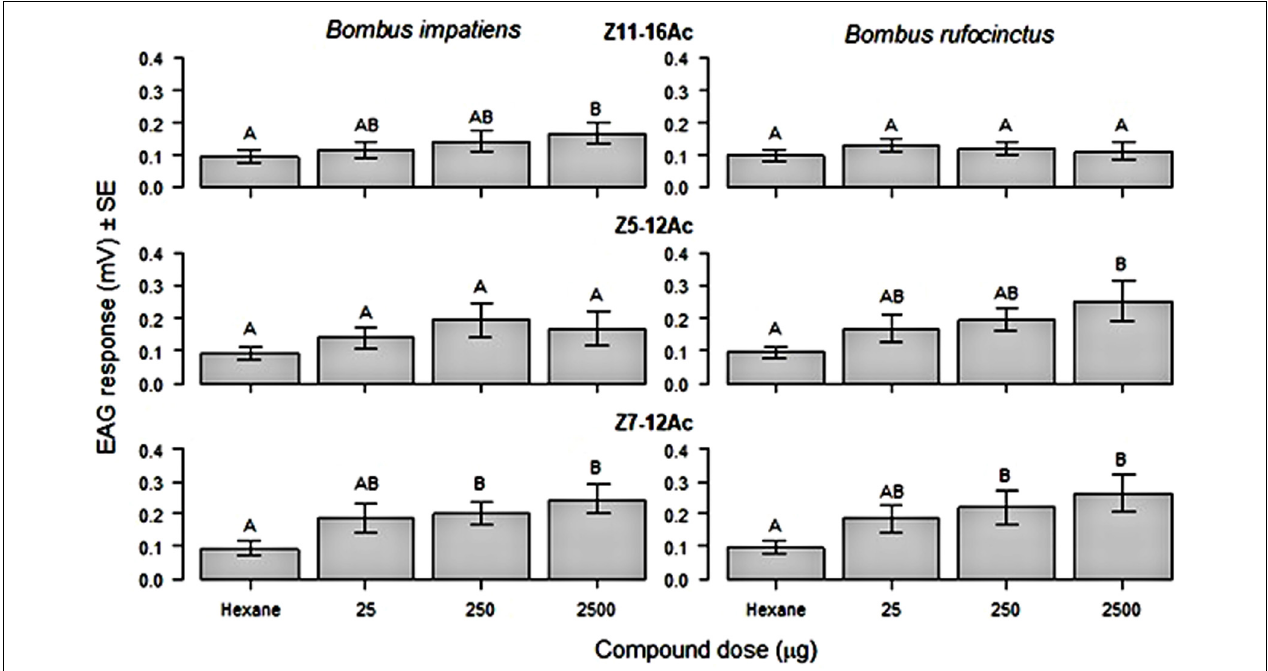
FIGURE 2 | Mean ( ± SE) electroantennogram (EAG) response (mV) generated from excised antennae of Bombus impatiens ( n = 10) and B. rufocinctus ( n = 10) workers stimulated with a hexane control and various doses of moth pest pheromone components: Z 11-16Ac, Z 5-12Ac, and Z 7-12Ac. Different letters indicate significant differences after means comparison (Tukey’s HSD: p <